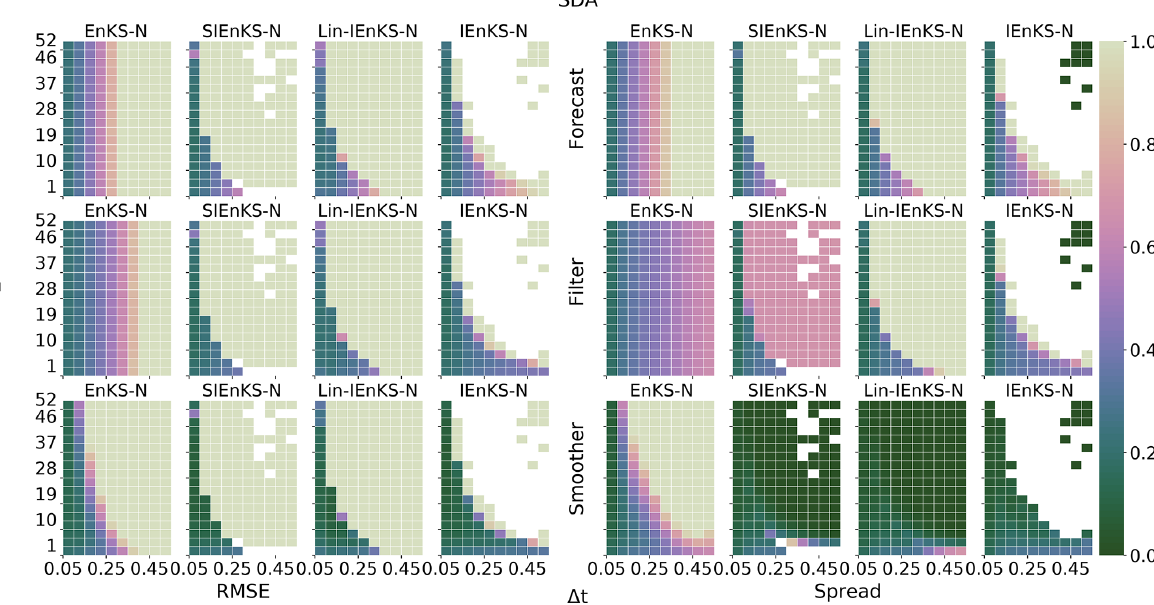
Figure 22. Lag length L on the vertical axis and (cid:49)t on the horizontal axis. SDA, adaptive inflation, and ensemble size N e = 21 are